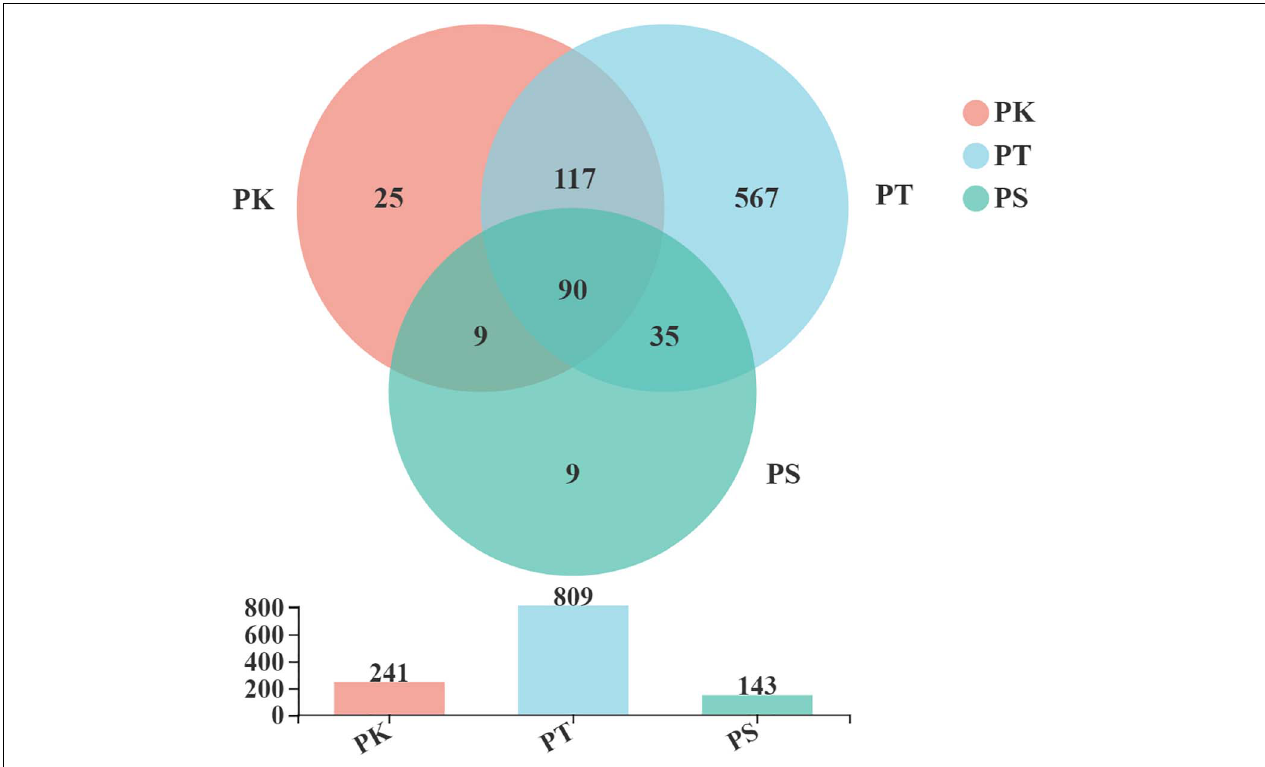
FIGURE 1 | Venn diagrams of OTUs shared between intestines of larvae feeding on the three host tree species. PK, midguts of larvae feeding on P. koraiensis ; PT, midguts of larvae feeding on P. tabuliformis ; PS, midguts of larvae feeding on P. sylvestris var. mongolica . All of these abbreviations apply to the following